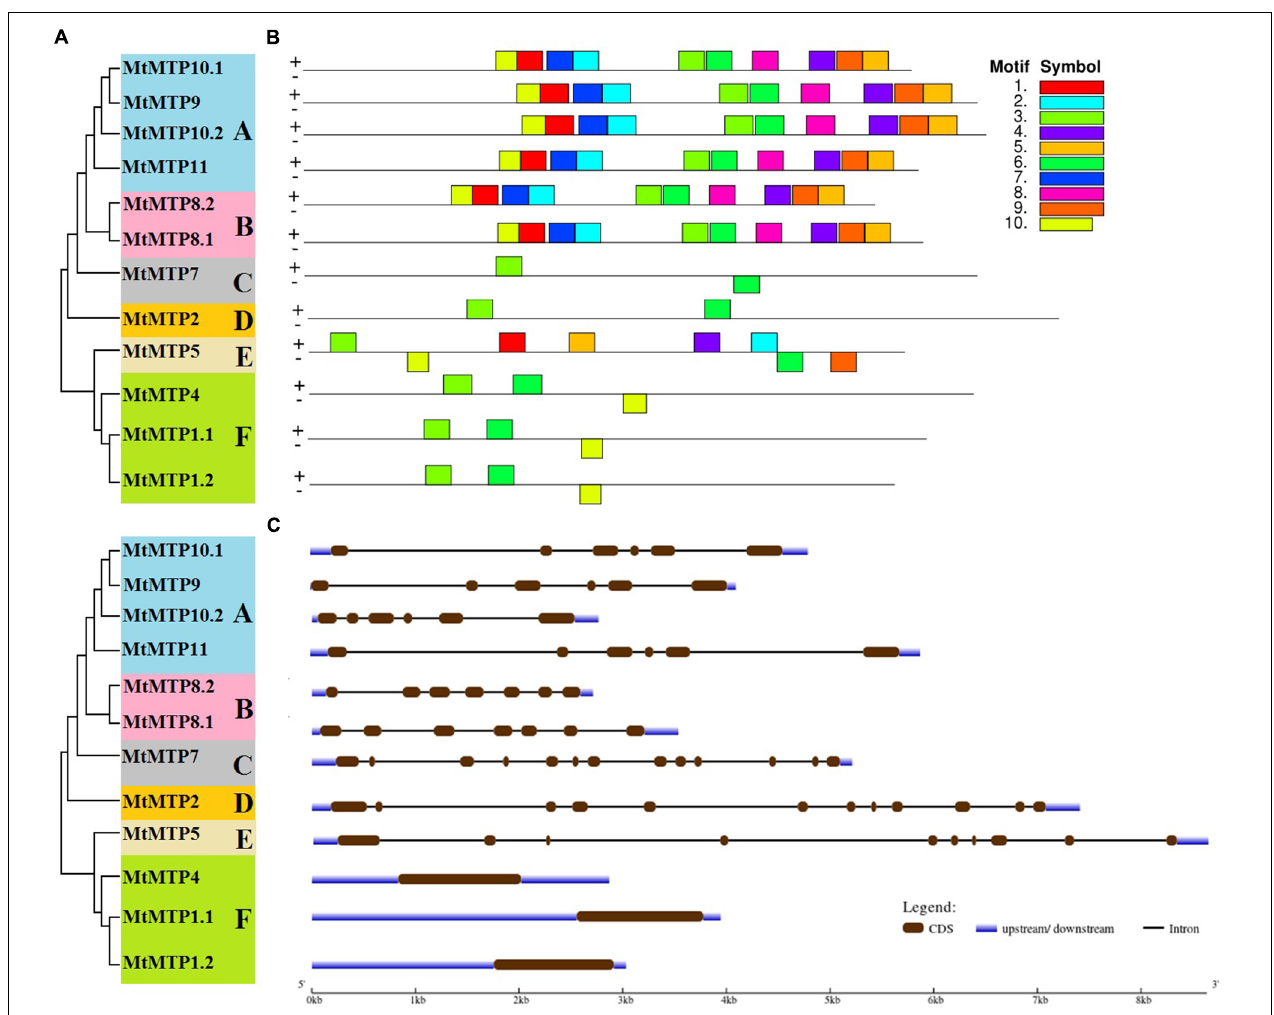
FIGURE 3 | Phylogenetic relationship, gene structure, and conserved motif analysis of MtMTP genes. (A) The neighbor-joining phylogenetic tree was constructed using MEGA6.0.6 using MtMTP amino acid sequences with 1,000 times replication. (B) The motif composition of MtMTP proteins using 10 conserved motifs is represented by the unique color mentioned in the box on the top left. (C) The exon-intron structure of M. truncatula MTP proteins, where dark green boxes represent the exons, and the black lines represent the introns. The blue boxes represent the untranslated regions (UTRs), with size scales detailed at the bottom.